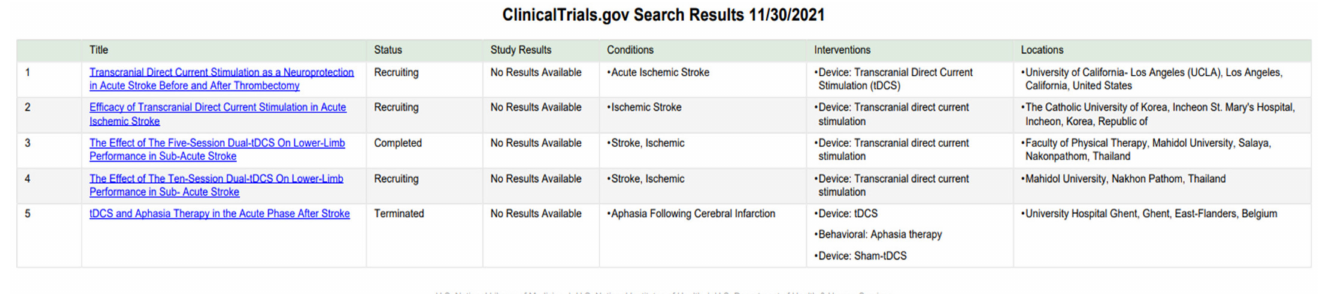
Figure 9. Clinical trials for Transcranial Direct Currents Stimulations interventions in acute ischemic stroke on https://clinicaltrials.gov (accessed on 16 December